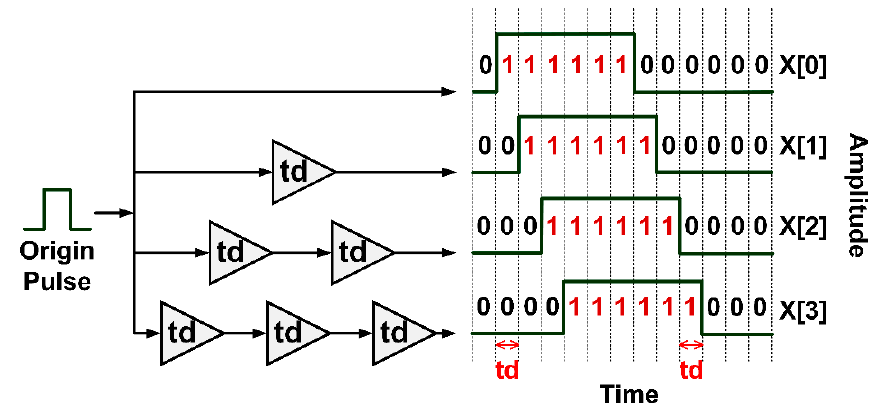
Figure 4. The staggered time-delay stratagem with four delay paths.